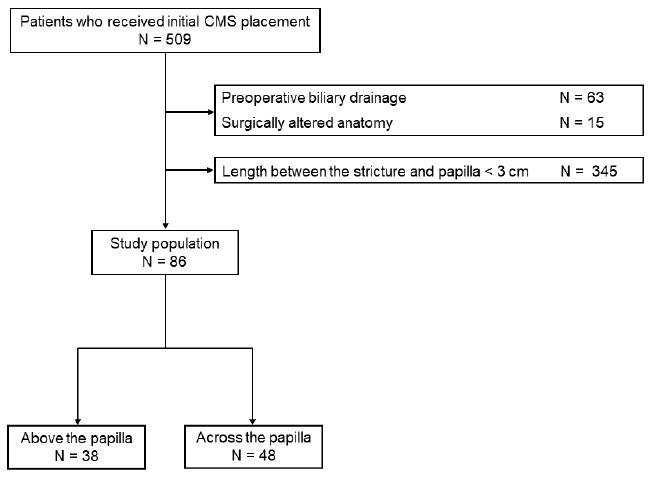
Figure 1. Patient flowchart. Figure 1. Patient Table 1. Baseline and procedural characteristics of patients who received covered metal stent above the papilla and across the papilla.